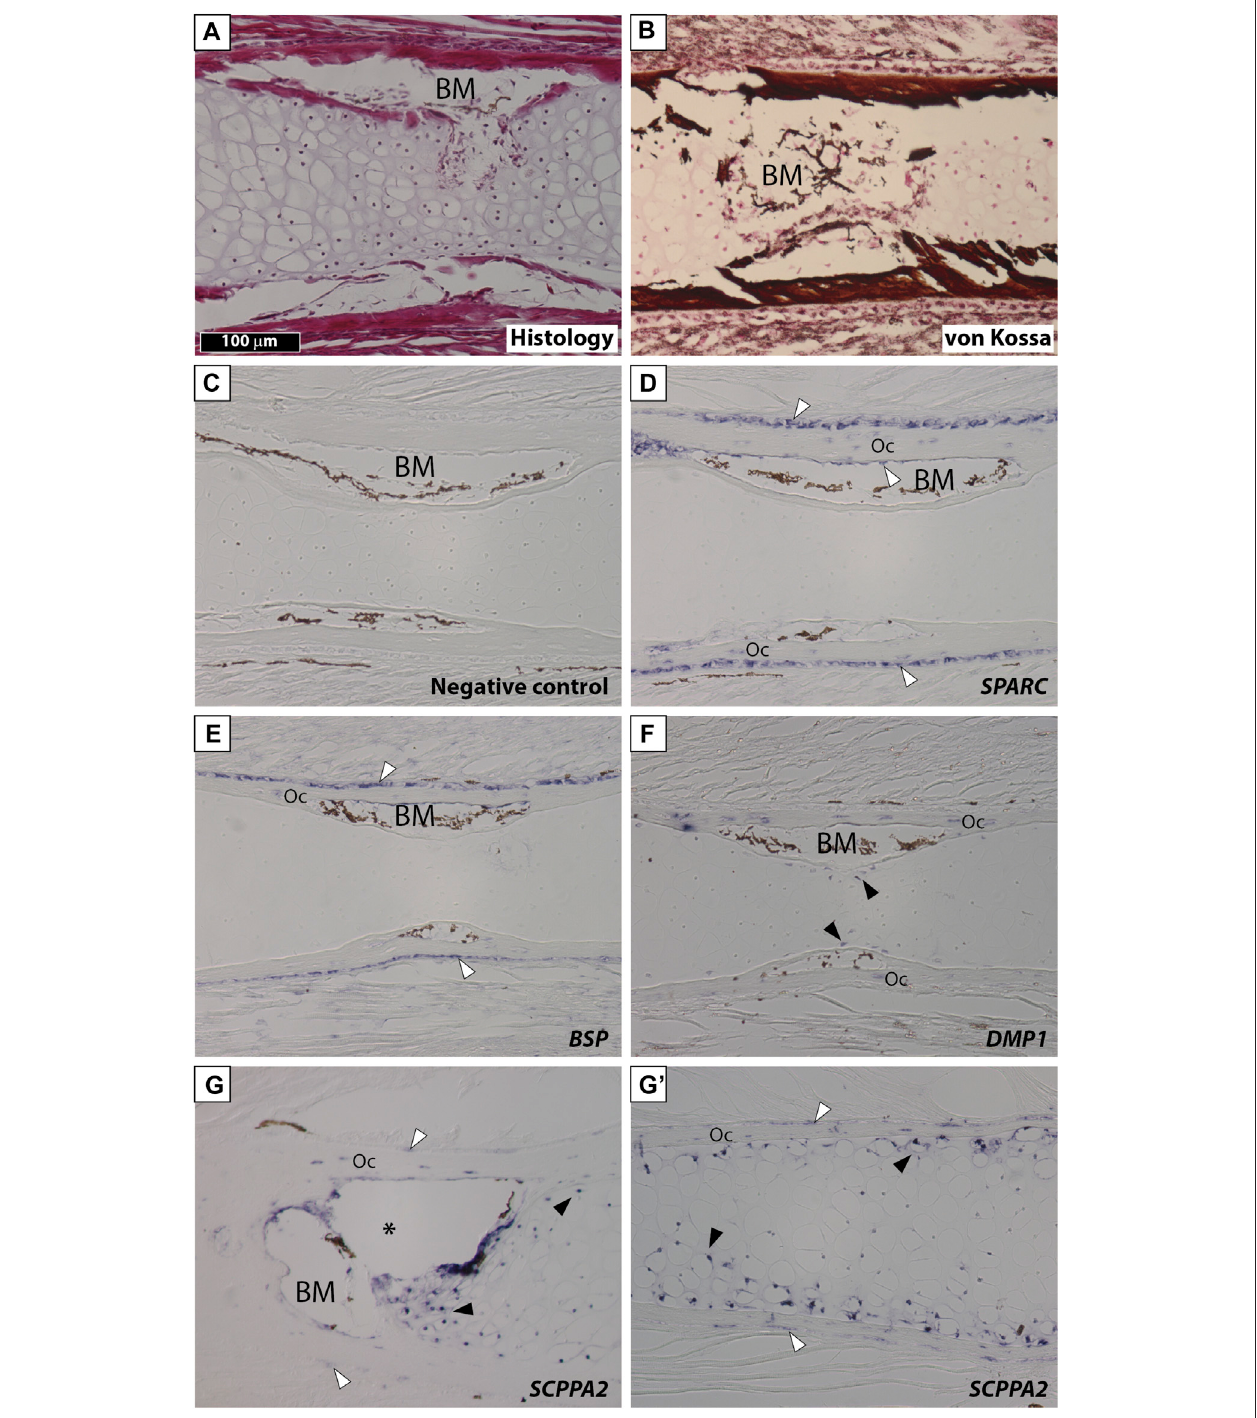
FIGURE3| SPARC and SCPP geneexpressionin Xenopustropicalis stageNF58hindlimbs.Longitudinalsectionsof Xenopustropicalis stageNF58femoralbones were subjected to Hematoxylin-Eosin staining (A) , von Kossa staining (B) , or in situ hybridization using a negative control [ SPARC sense probe, (C) ] or an antisense probefor SPARC (D) , BSP (E) , DMP1 (F) ,and SCPPA2 (G,G 9 ) .Picturesshowthediaphysisin (A – G) andtheepiphysisin (G 9 ) .Whiteandblackarrowheadsshow insitu hybridization signal in osteoblasts and chondrocytes, respectively. Abbreviations: BM, bone marrow, Oc osteocytes showing in situ hybridization signal. Scale bar in (A) represents 100 µm and applies to all panels. The asterisk shows an artifact due to the cartilage which teared apart and contracted in this region of the section.